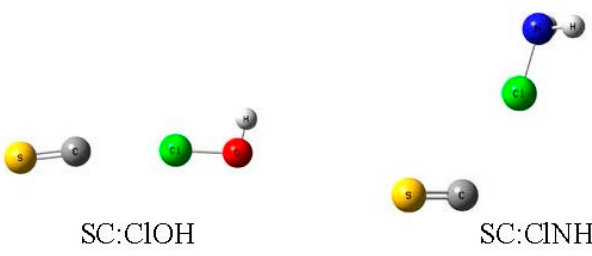
Figure 6. Complexes SC:ClOH and SC:ClNH 2 .